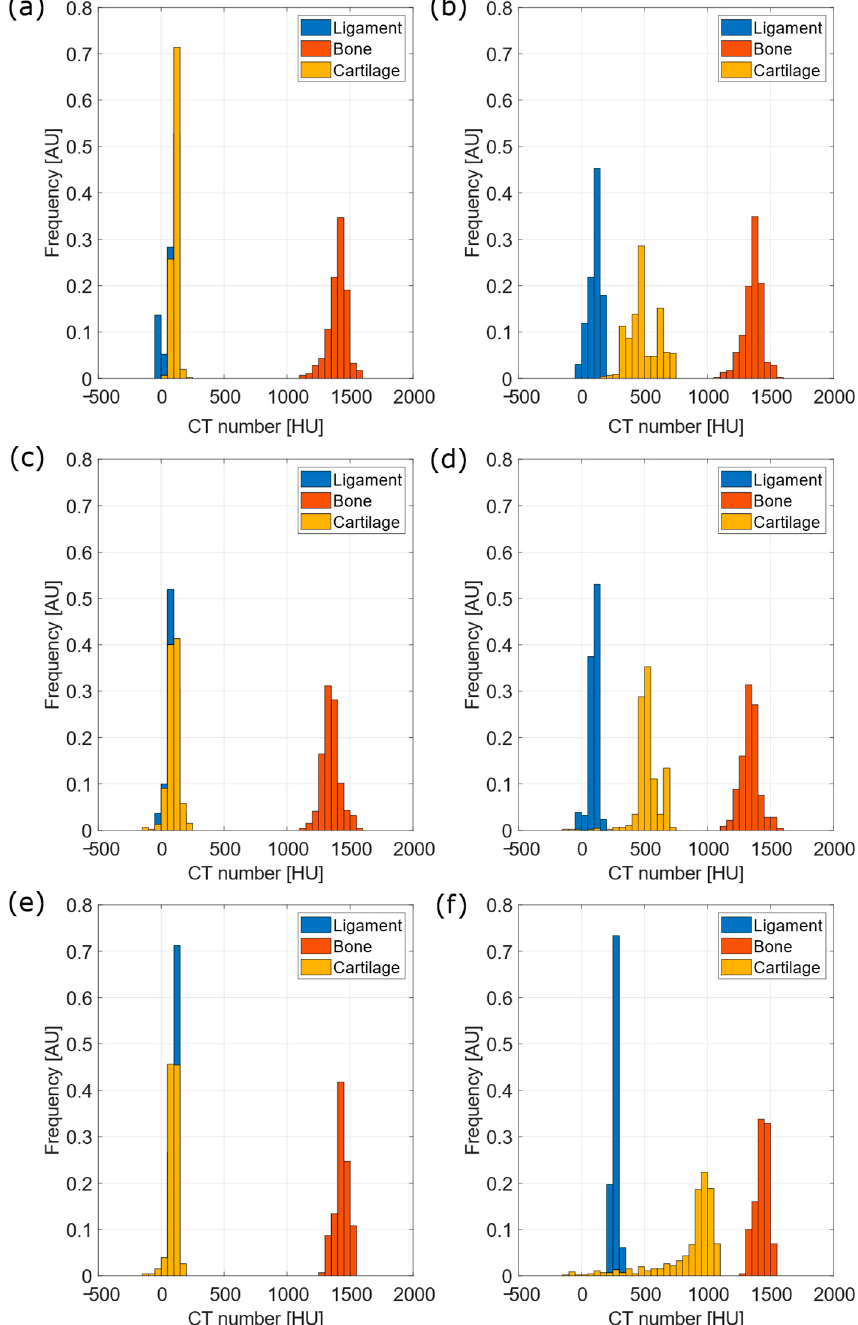
Figure 6. Histograms of CT number distribution, from ROIs drawn on tibiae acquisitions, distinguishing three different tissue types, namely connective, bone and cartilage. On the left, the distributions of CT numbers prior to CA4+ immersion are reported ( a , c , e ). On the right, the distributions of CT numbers after the 24-h CA4+ immersion are reported ( b , d , f ). From the top, 5 mgI/mL, 10 mgI/mL and 15 mgI/mL-concentration data are displayed.